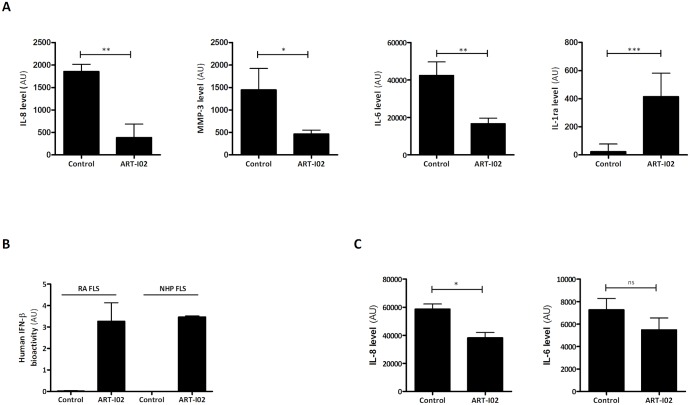
Bioactivity of ART-I02 in human and NHP FLS.In the presence of hIFN-β the anti-inflammatory cytokine IL-1ra was up regulated in RA FLS (A). Levels of pro-inflammatory cytokines (IL-6, IL-8) as well as MMP-3 were downregulated in RA FLS (A). A quantitative gene reporter bioassay confirmed the presence of bioactive hIFN-β after transduction of ART-I02 in combination with stimulation both in RA FLS as well as NHP FLS (B). In NHP FLS (C), IL-8 was also downregulated significantly, although IL-6 in NHP FLS showed only a trend towards downregulation. All samples were stimulated with TNF-α, except for the human IL-6 data, where samples were stimulated with TNF-α and IL-1β. Control cells were stimulated but not transduced with ART-I02. Data shown are mean + SD, N = 2–6 experiments, * indicates P<0.05, ** P<0.01 and *** P<0.001.